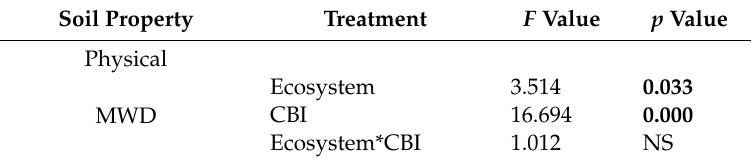
Figure 2. Average of mean weight diameter (MWD) resistance index values and standard error for each forestry ecosystem (shrubland, heathland, and oak forest) and burn severity level (low, moderate, and high) measured by the Composite Burn Index (CBI). Table 3. Results of the two-way ANOVA showing the effects of the factor ecosystem (shrubland, heathland, and oak forest), the effects of the burn severity variable (low, moderate, and high), and the interaction between ecosystem and burn severity (*), on the resistance index of each soil property (response variable). Significant p values are in bold face. NS (not significant).